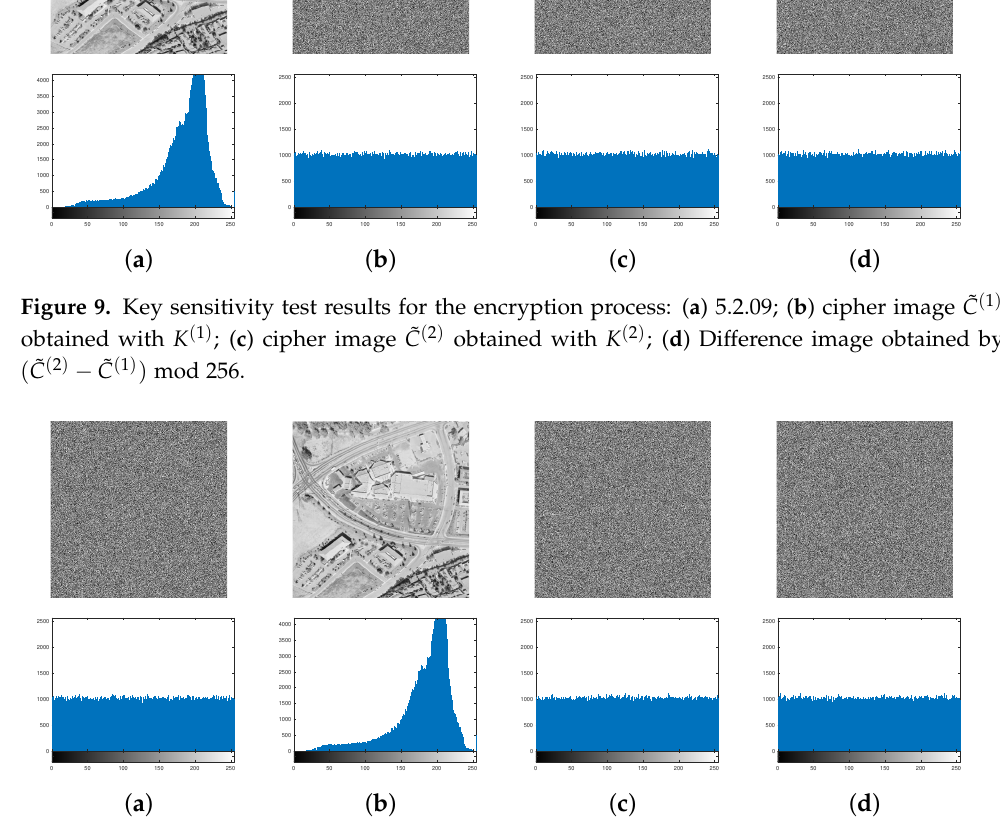
Figure 10. Key sensitivity test results for the decryption process: ( a ) cipher image ˜ C ( 1 ) obtained with K ( 1 ) ; ( b ) decrypted image ˜ D ( 1 ) obtained with K ( 1 ) ; ( c ) decrypted image ˜ D ( 2 ) obtained with K ( 2 ) ; ( d ) Difference image obtained by ( ˜ D ( 2 ) − ˜ D ( 1 ) ) mod